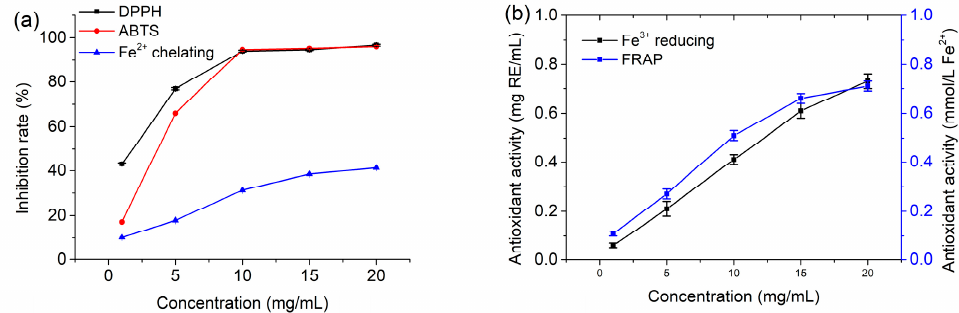
Figure 5. The antioxidant activities of DES extract in different concentrations. ( a ) DPPH, ABTS, and Fe 2+ chelating assay. ( b ) Fe 3+ reducing and FRAP assay.